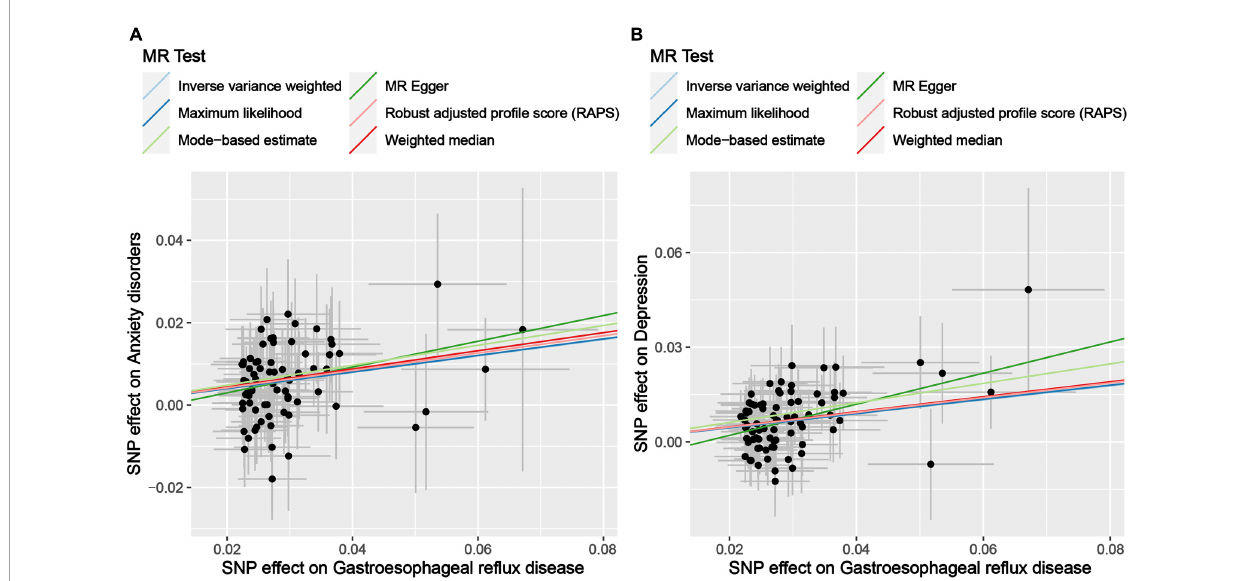
FIGURE3 Scatter plot of genetic correlations of exposure and outcome based on the IVs screened under the locus-wide significance threshold. (A) Scatter plot of genetic correlations of GERD and anxiety disorders. (B) Scatter plot of genetic correlations of GERD and depression.